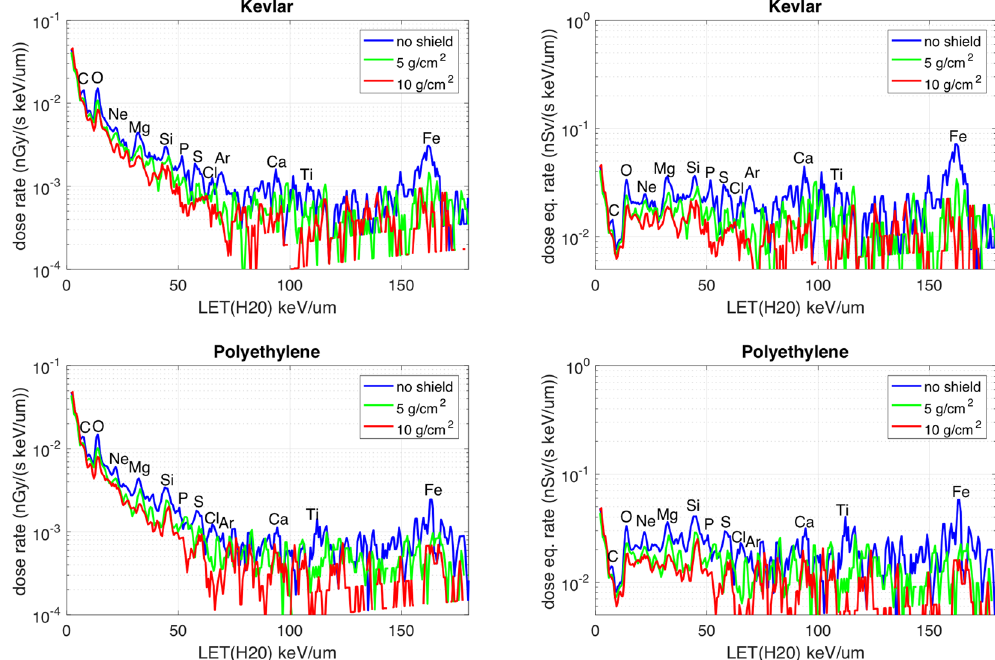
Figure 3. Dose rate and Dose equivalent rate spectra. Dose rate (left) and dose equivalent rate (right) spectra for Polyethylene (lower plots) and Kevlar (upper plots). Spectra are plotted vs. Linear Energy Transfer (LET, in water). Each spectrum shows three traces: blue = reference measurements with no shield; green = measurements with 5 g/cm 2 shield tiles; red = measurements with 10 g/cm 2 shield tiles. The symbols of the elements of the most prominent peaks are indicated.